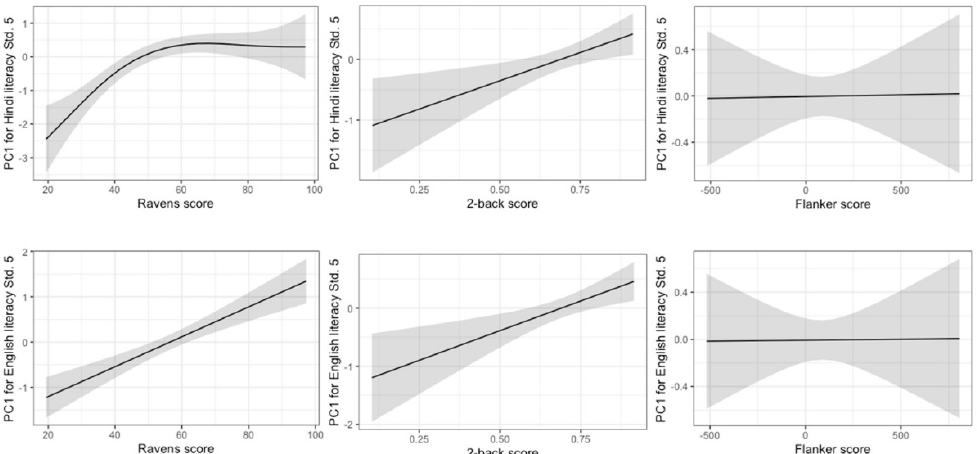
Figure 4. Relations between cognitive abilities and literacy performance in Std. 5 in Hindi and English. Shaded areas indicate 95% confidence interval. Positive relations were found between literacy and Ravens score and literacy and 2-back score in both languages. No significant relations were found between Flanker score and literacy in either of the languages.